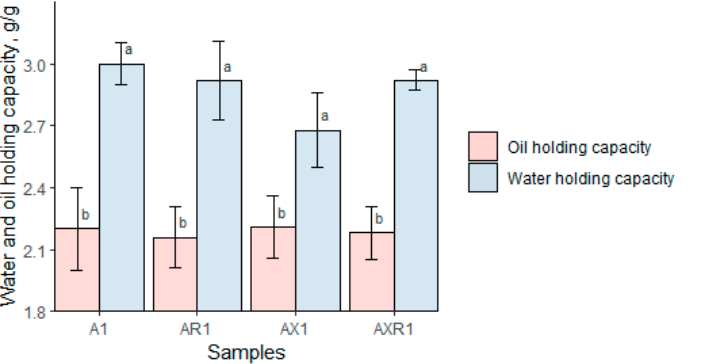
Figure 7. Water and oil-holding capacity ratios, g/g. Different letters indicate significant differences within the samples ( p < 0.05).